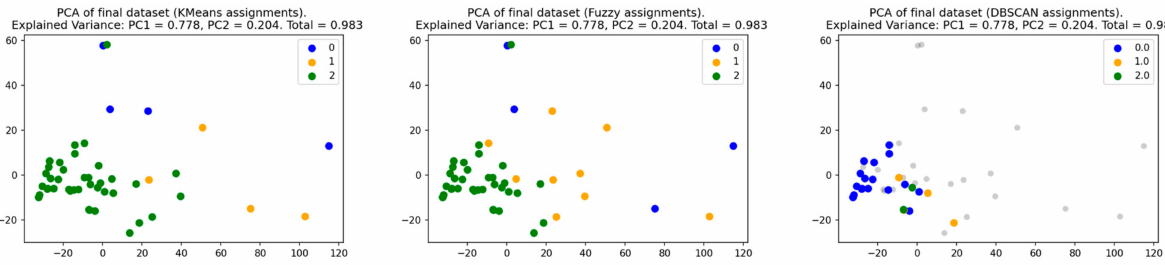
Figure 7. Cluster analysis in the final measurement (eight weeks after the beginning of the semester) with the k -means ++, fuzzy k -means, DBSCAN